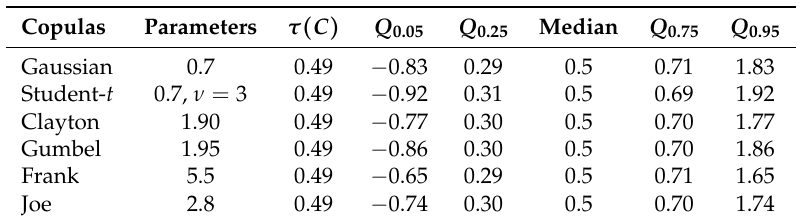
Table 14. Some percentiles of Y = X 1 / ( X 1 + X 2 ) , where ( X 1 , X 2 ) modelled with six copulas having the same Kendall coefficient τ = 0.49 .